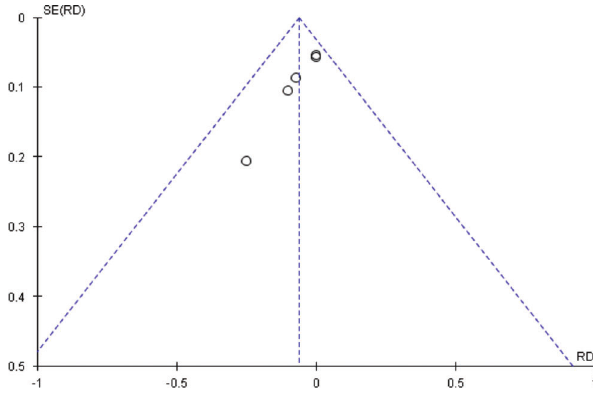
Figure 7 - Funnel plot of mortality related to procedures in retrospective studies. All studies are inside the funnel plot.